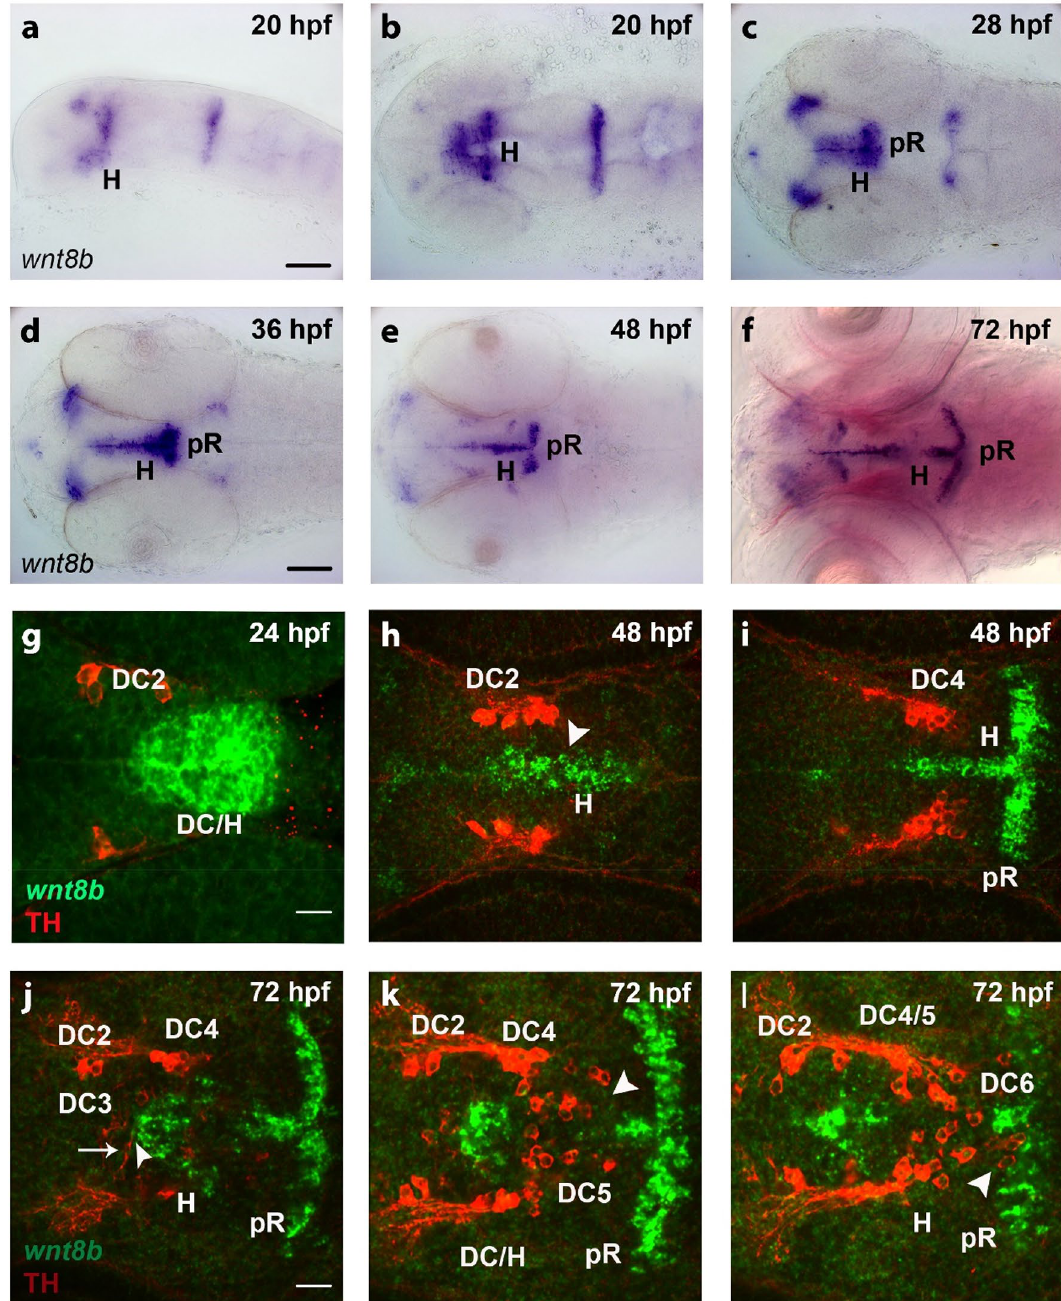
Figure 1. Expression of wnt8b in the ventral diencephalon and hypothalamus and in relation to dopaminergic neurons. ( a – f ) Expression of wnt8b in embryos as detected by whole mount in situ hybridization at stages as indicated. Lateral ( a ) and dorsal ( b – f ) views of heads of embryos, images generated from Z-projections of image stacks. Scale bars in ( a ) and ( d ) are 100 µm for ( a – f ). ( g – l ) Expression of wnt8b detected by fluorescent in situ hybridization (green) in relation to TH-immunoreactive DA neurons detected by immunofluorescence (red) in embryos at stages as indicated. Dorsal views of the ventral diencephalon/hypothalamus region. Confocal image stacks were recorded and images show single optical sections of Z-stacks containing TH-immunoreactive cells. DA neuron groups DC2 and DC4 of the ventral diencephalon and DC5 and DC6 of the hypothalamus are labeled. ( h , i ). Two optical sections of a single 48 hpf embryo at 13.97 µm distance from dorsal ( h ) to ventral ( i ). ( j – l ) Three optical section of a single 72 hpf embryo at ( j – k ) 13.97 µm and ( k – l ) 5.08 µm distances, with the dorsalmost section shown in ( j ). Scale bar in ( g ) is 20 µm for ( g – l ). ( g – l ) Z-stacks are included as video files in Supplementary Information as Supplementary Video 1 ( g ), Supplementary Video 2 ( h – i ), and Supplementary Video 3 ( j – l ). Scale bar in ( g ) is 20 µm for ( g – i ) and scale bar in ( j ) is 20 µm for ( j – l ). DC diencephalon, H hypothalamus, pR posterior